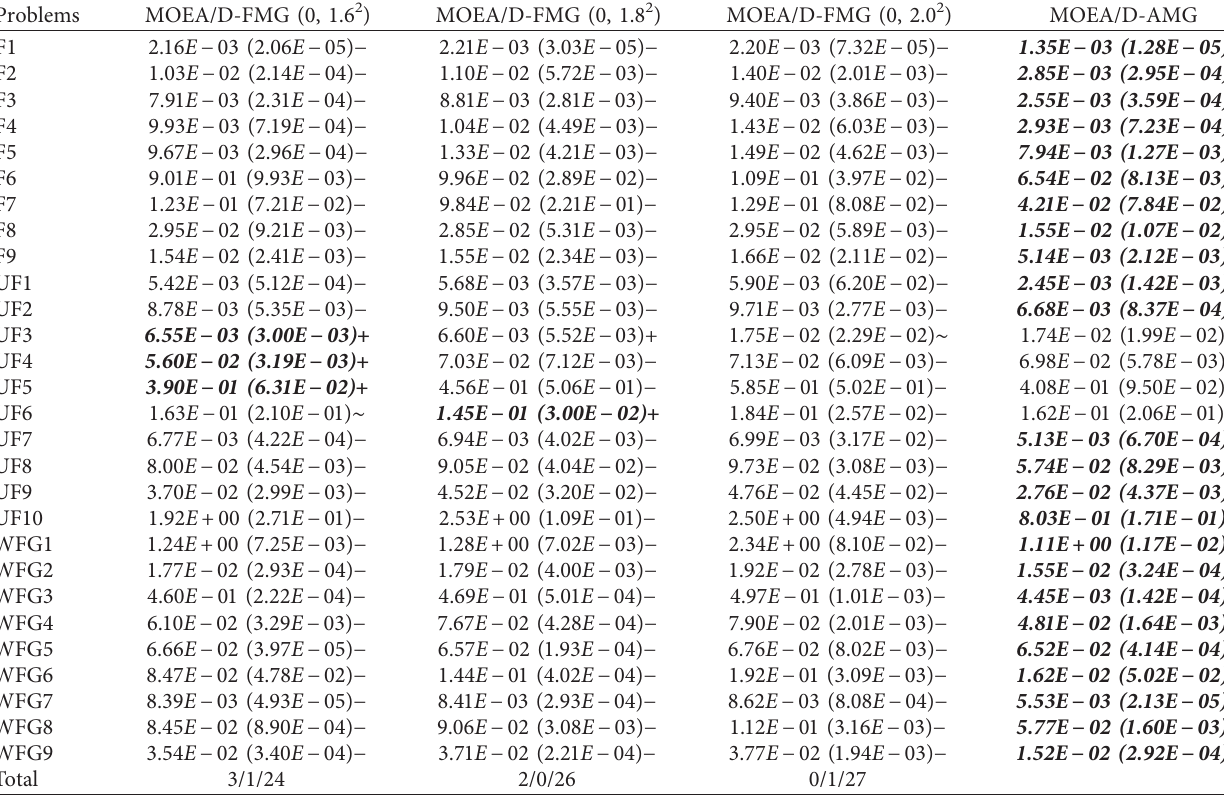
Table 5: Performance comparison of MOEA/D-FMG with various Gaussian distributions and MOEA/D-AMG in terms of the average IGD values and standard deviations on F, UF, and WFG problems.